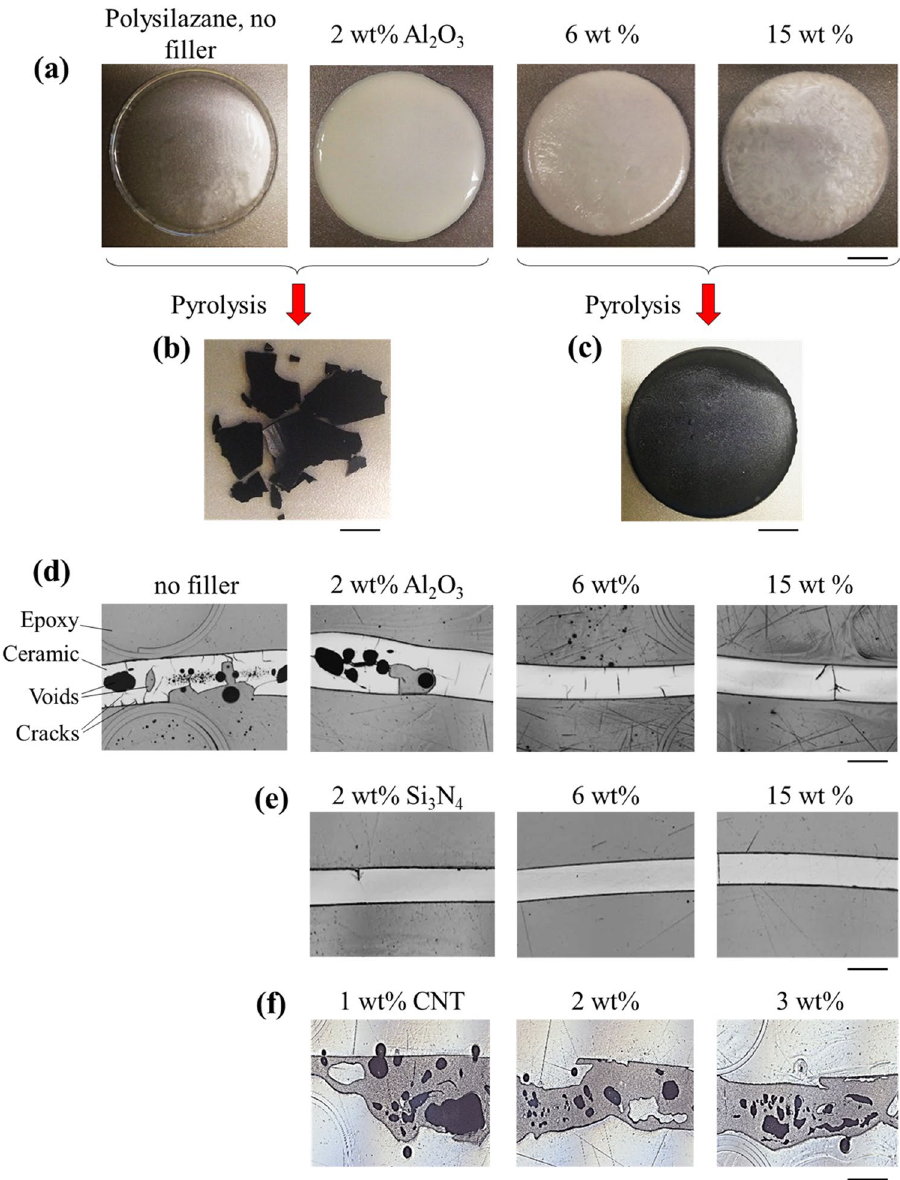
Figure 1. Nano-modified preceramic polymers. ( a ) Optical images of samples with different concentrations of alumina nano-fillers before the pyrolysis, and ( b , c ) After the pyrolysis. ( d – f ) Optical microscopy images of PDCs with different concentrations of ( d ) Al 2 O 3 , ( e ) Si 3 N 4 , and ( f ) CNTs. Scale bars are ( a–c ) 15 mm, ( d–f ) 2